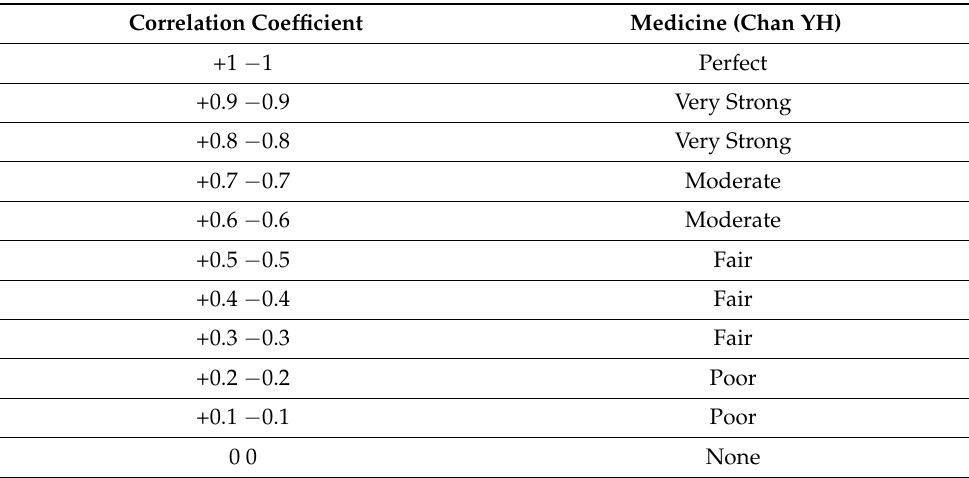
Table 3. Guide to interpretation of the correlation coefficient.